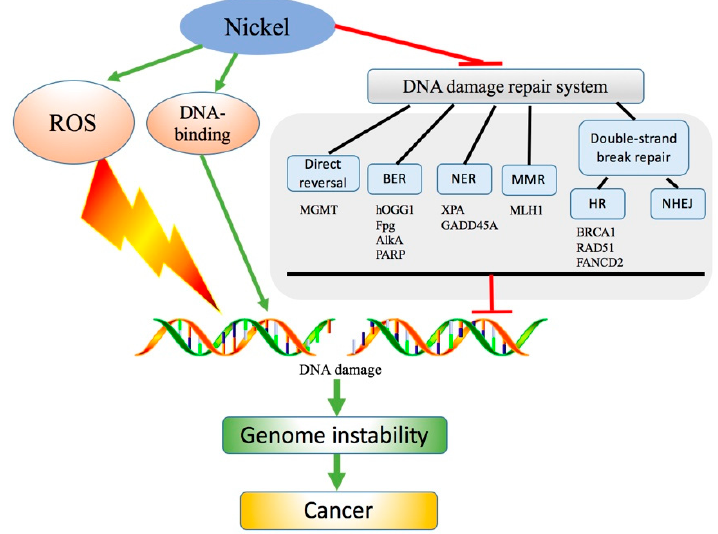
Figure 3. Simplified scheme of Ni-induced DNA damage in cancer occurrence. Excessive exposure to Ni can induce DNA damage, mainly through direct DNA binding and ROS generation. Ni can also repress the DNA damage-repair pathways, including direct reversal, BER, NER, MMR, HR, and NHEJ repair. DNA damage causes genome instability that may ultimately contribute to cancer occurrence.